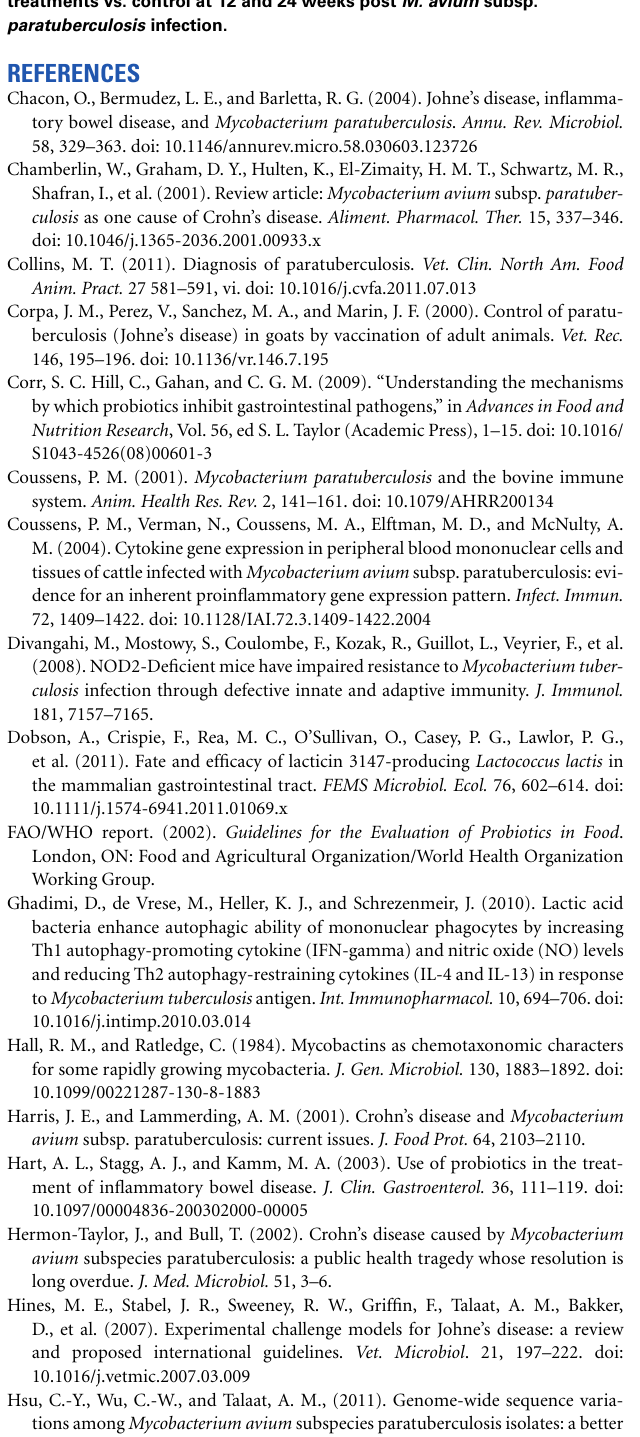
Figure S1 | M. avium subsp. paratuberculosis organ colonization from therapeutic Lactobacillus casei ATCC 334 treatments at 24 weeks post oral M. avium subsp. paratuberculosis K10 infection. Figure S2 | Cytokine profiles of therapeutic Lactobacillus casei ATCC 334 treatment versus control at 24 weeks post oral M. avium subsp. paratuberculosis K10 infection. Figure S3 | IFN γ /IL-10 ratios for different Lactobacillus casei ATCC 334 treatments vs. control at 12 and 24 weeks post M. avium subsp. paratuberculosis